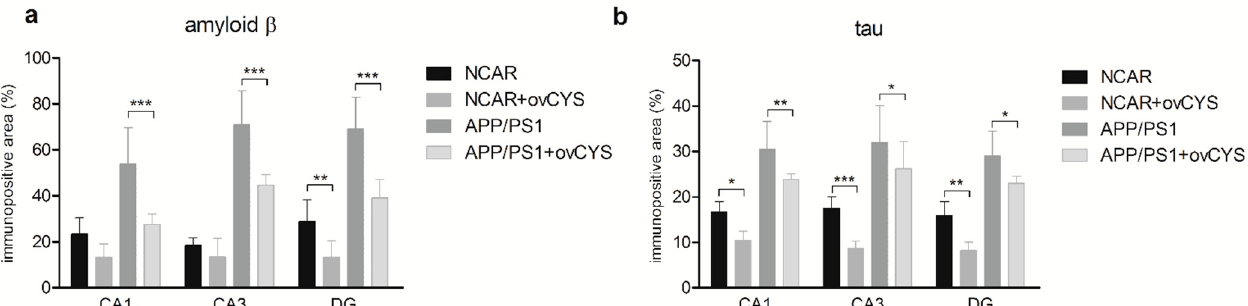
Figure 1. Immunoreactive area (percentage of the total area measured) of β -amyloid ( a ) and tau ( b ) burden in three hippocampal regions. ( a ) the burden of β -amyloid significantly decreased in the ovocystatin-treated transgenic group within all analyzed regions of the hippocampus, ( b ) deposits of misfolded tau protein significantly decreased in both non-carrier and transgenic ovocystatin-treated groups within all analysed hippocampal regions. NCAR – non-carrier group, NCAR+ovCYS – ovocystatin-treated non-carrier group, APP/PS1 – transgenic group, APP/PS1+ovCYS - ovocystatin-treated transgenic group. Statistical significance of treated ovCYS versus untreated groups was indicated as * at p < 0.05, ** at p < 0.01, and *** at p < 0.001 within the respective hippocampal region.